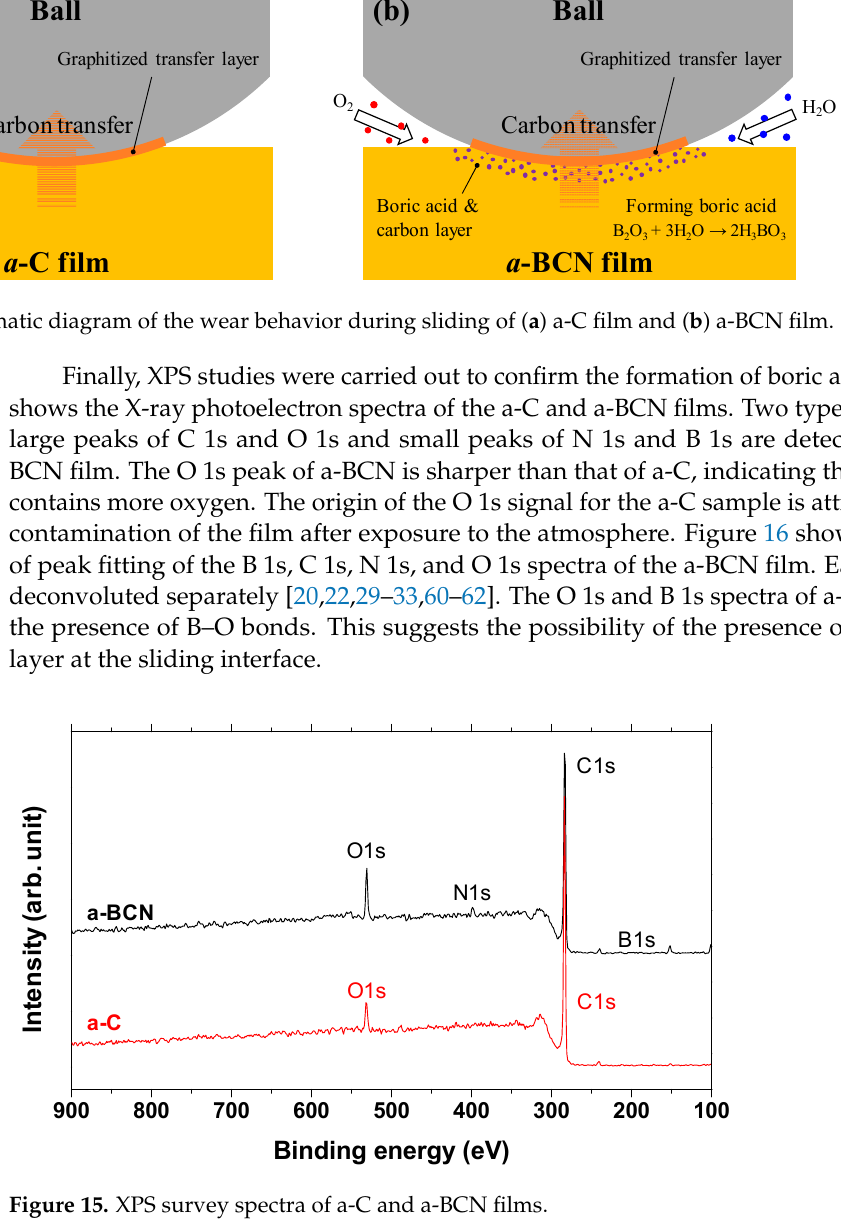
Figure 15. XPS survey spectra of a-C and a-BCN films.